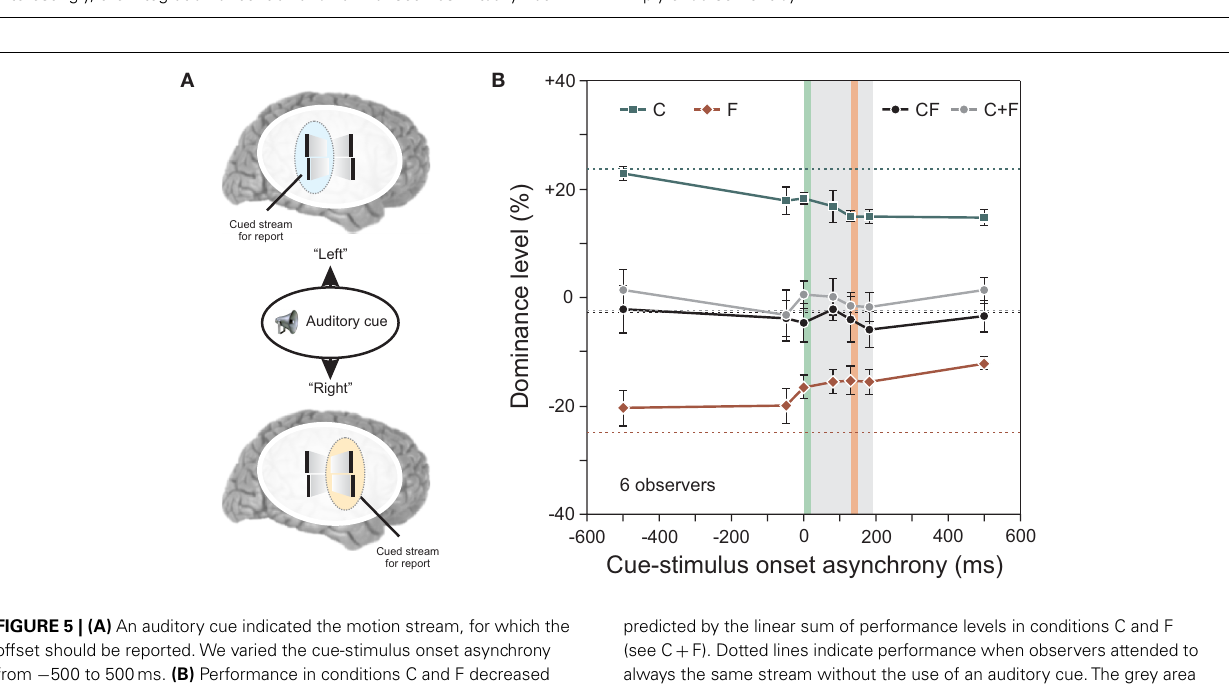
FIGURE 4 | (A) We extended the experiment shown in Figure 1 by adding more and more flanking lines to the sequence (i.e., sequences with 4, 6, 8, or 10 pairs of flanking lines).The flank-offset was always presented in the penultimate frame (no offset is shown in the illustration). (B) We presented only the central-offset (C), only the flank-offset (F), or both offsets together in the attended stream (CF). In general, dominance decreased (as indicated by absolute values closer to 0) for longer lasting sequences, i.e., the more non-offset flanking lines were added. Interestingly, the integration of central- and flank-offset was virtually not